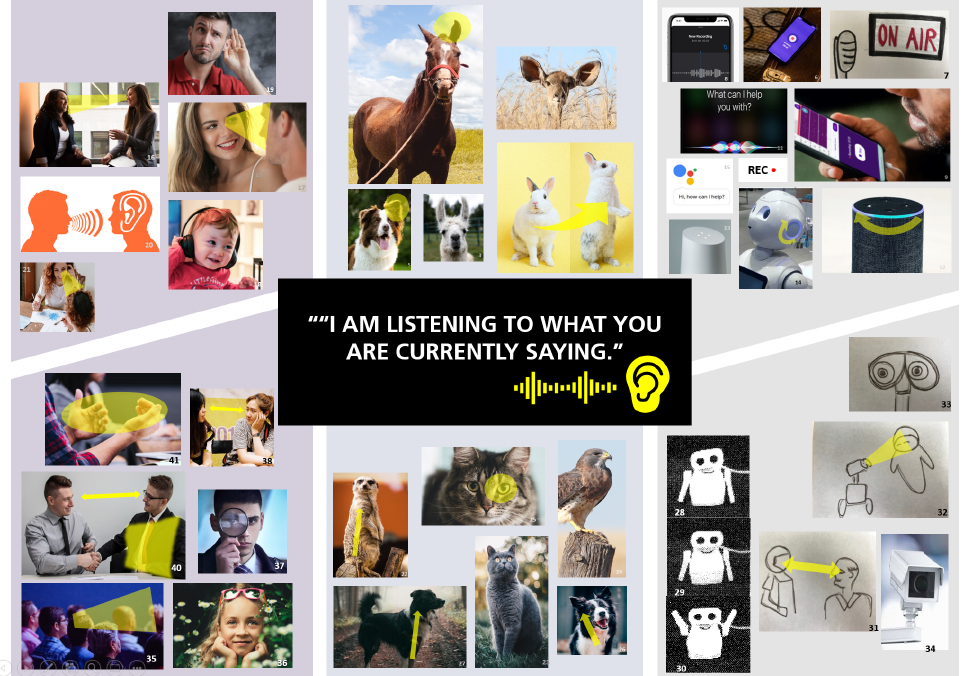
Figure 3. Insight Board for the robot action “listen to user”. Sources of the images used for the insight board can be found in Appendix A Figure